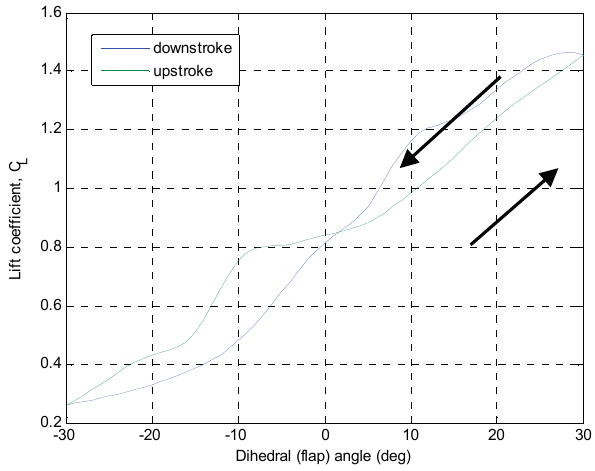
Figure 10. Lift coefficient during downstroke and upstroke motion of the wing.